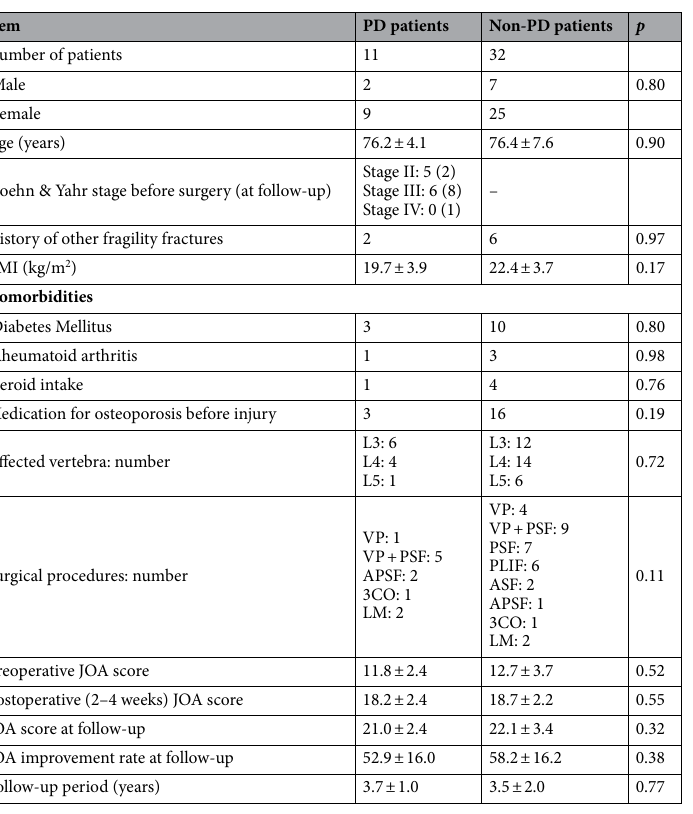
Table 1. Demographic data for patients with low lumbar osteoporotic vertebral collapse with and without Parkinson’s disease. PD Parkinson disease, BMI Body mass index, VP Vertebroplasty, PSF Pedicle screw fixation, PLIF Posterior lumbar interbody fusion, ASF Anterior spinal fusion, APSF Anterior and posterior spinal fusion, 3CO 3 Column osteotomy, LM